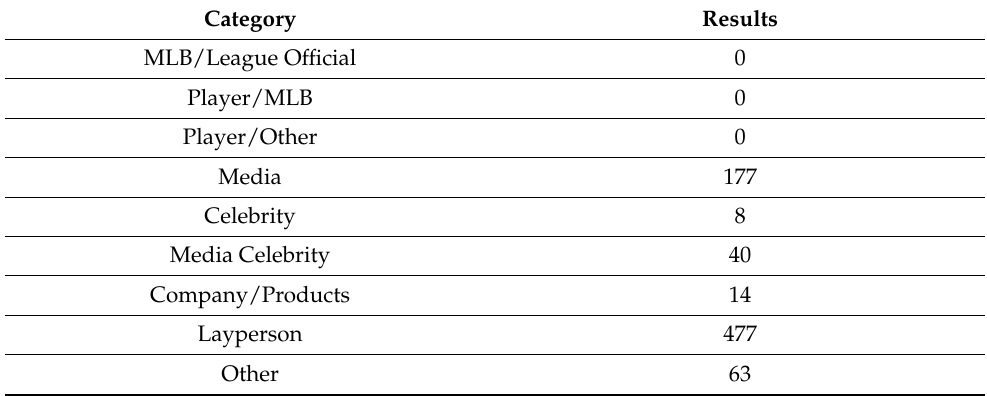
Table 4. Sources of tweets.